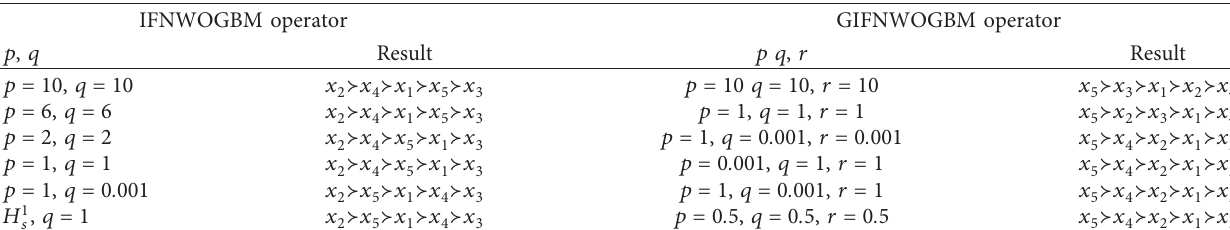
Table 4: Decision-making results.